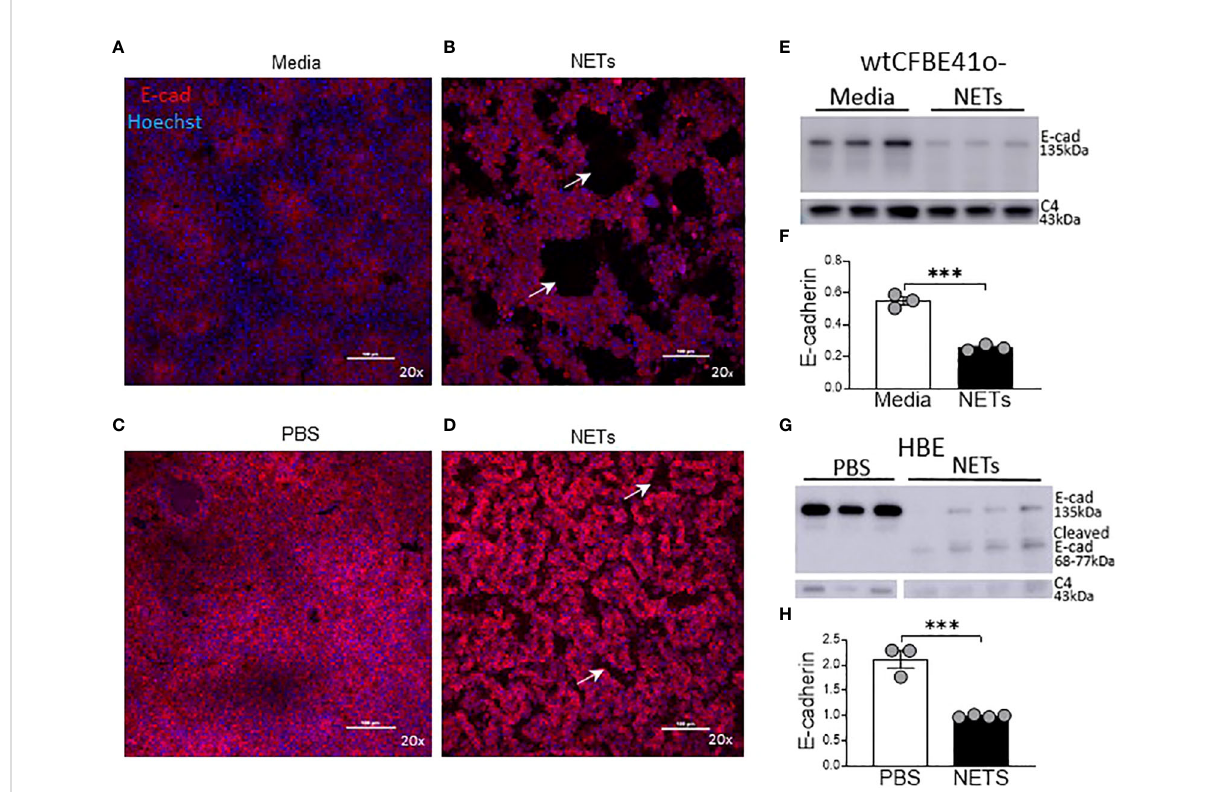
FIGURE 4 NETs disrupt epithelia monolayers and decrease E-cadherin. Confocal microscopy images (20x) of human epithelia stained for E-cadherin/ AF647 and DNA/Hoechst. (A) Con fl uent wtCFBE41o- exposed to media or (B) 15µg/ml NETs for 18h, the latter with visible holes (arrows) in the monolayer. (C) HBE grown at ALI exposed to PBS or (D) 5 m g/ml NETs for 18h, the latter with disruptions (arrows) in the monolayer. (E) Representative western blot and (F) analysis of E-cadherin protein from lysates of wtCFBE41o- exposed to PBS or 15µg/ml NETs for 18h. (G) Representative western blot and (H) analysis of E-cadherin protein from lysates of HBE exposed to PBS or 5µg/ml NETs for 18h. E-cadherin was normalized to C4-actin. Data analyzed by unpaired t-test (experiments=3, HBE donors=3, NET donors=3).